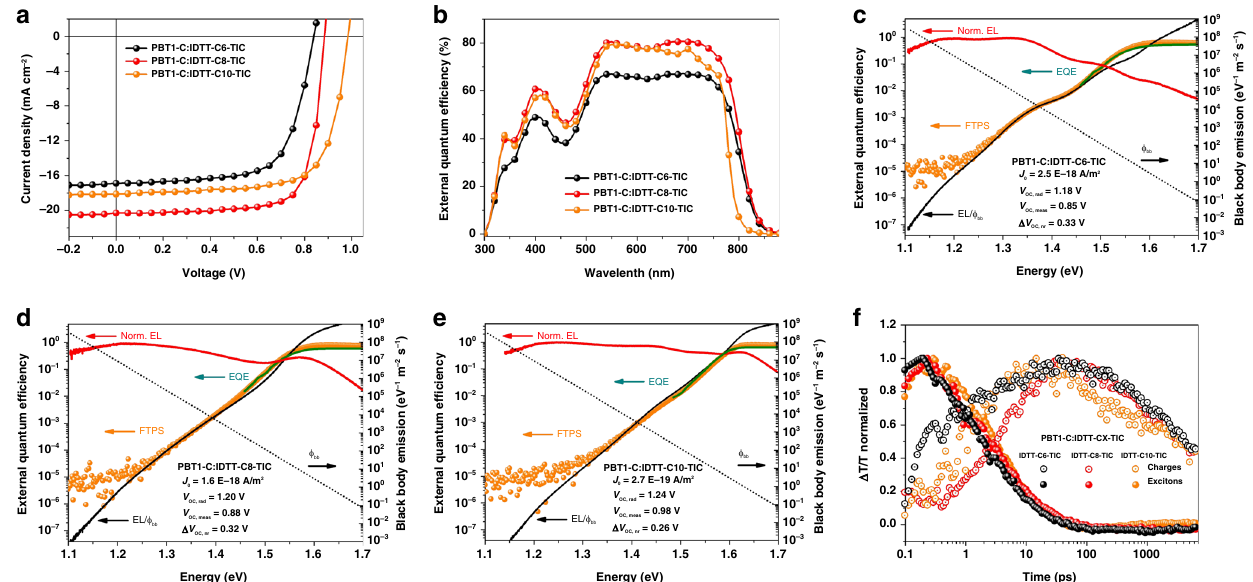
Fig. 4 Photovoltaic performance, energy loss analysis, and transient absorption kinetics of blend fi lms. a Current – voltage characteristics of the binary devices based on PBT1-C and IDTT-CX-TIC. b External quantum ef fi ciencies (EQEs) of the binary devices. c , d , e Semi-logarithmic plots of normalized EL (red line), measured EQE (olive line) and EQE calculated by Fourier-transform photocurrent spectroscopy (FTPS) (orange dots) as a function of energy for devices based on PBT1-C and different acceptors. Dark gray dot line is black body radiation ( ϕ bb ) at 300 K. The ratio of EL and ϕ bb was used to plot the EQE in the low energy regime (black line). Inset in each fi gure shows the saturated current density for radiative recombination ( J 0 ), radiative V OC limit ( V OC, rad ), measured V OC ( V OC, meas ), and non-radiative V OC losses ( Δ V OC, nr ). f Transient absorption kinetics of excitons and charges in the blends, after the selective excitation of the corresponding acceptor phases at 710 nm at pump fl uences of 13 µ J/cm 2 , 4.7 µ J/cm 2 and 4.7 µ J/cm 2 respectively. The plots are produced via bilinear decomposition of the TA surfaces using spectral mask of excitons from relevant neat acceptor fi lms (Supplementary Fig.